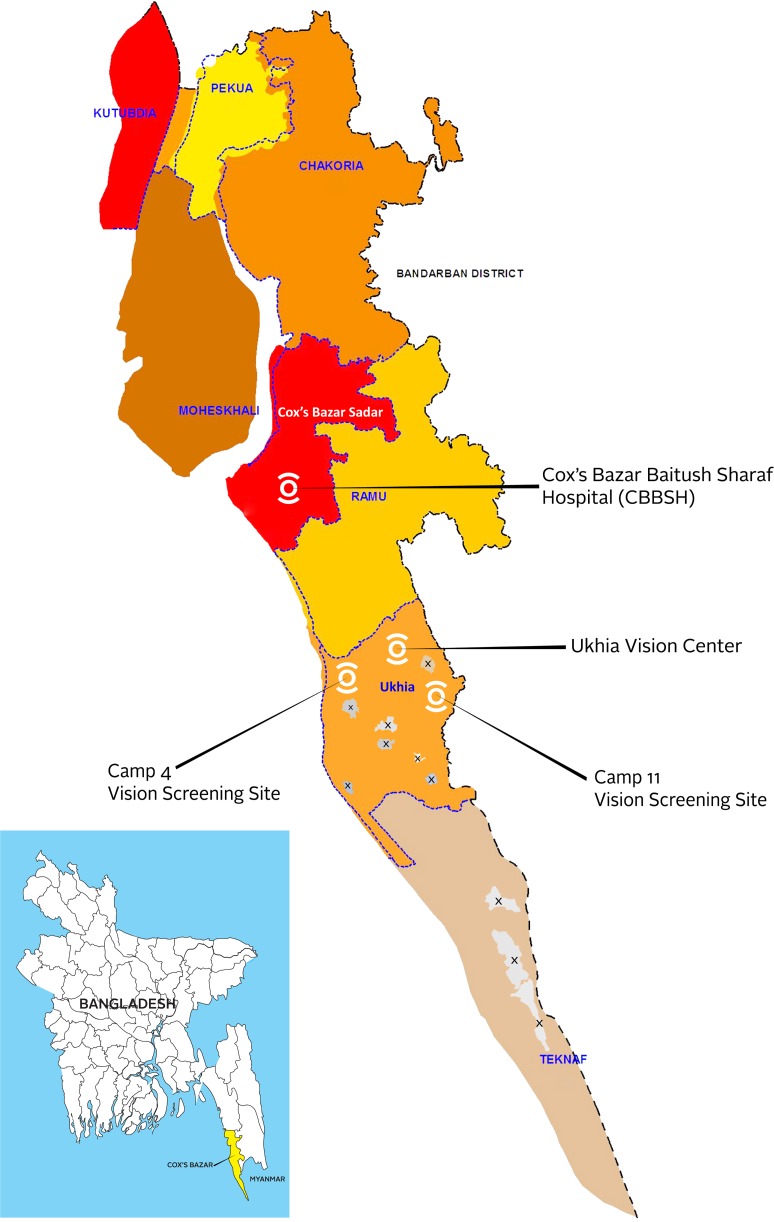
A map of Cox’s Bazaar, showing the study area including vision screening locations.Locations of the Rohingya camps are denoted with shaded Xs. The base map was obtained from OCHA
https://www.humanitarianresponse.info/en/operations/bangladesh/infographic/coxs-bazar-access-road-network-camp-boundary-january-2020, CC Attribution 4.0.